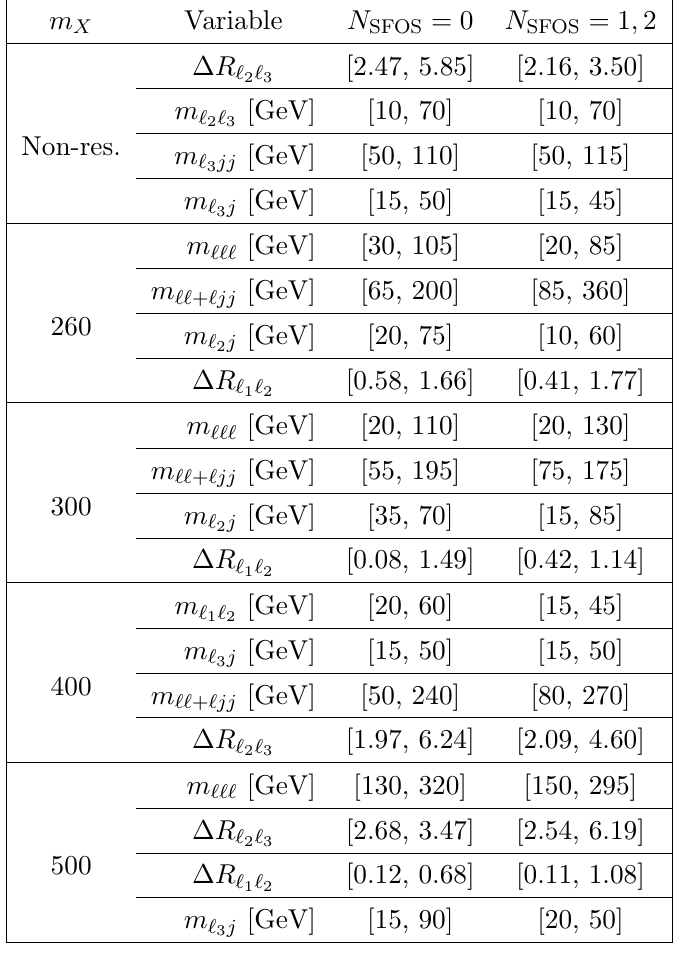
Table 8 . Optimised selection criteria for non-resonant and resonant HH searches in the three lepton channel. The selection criteria are chosen to ensure constant signal selection e(cid:14)ciency between the N SFOS = 0 and N SFOS = 1 ; 2